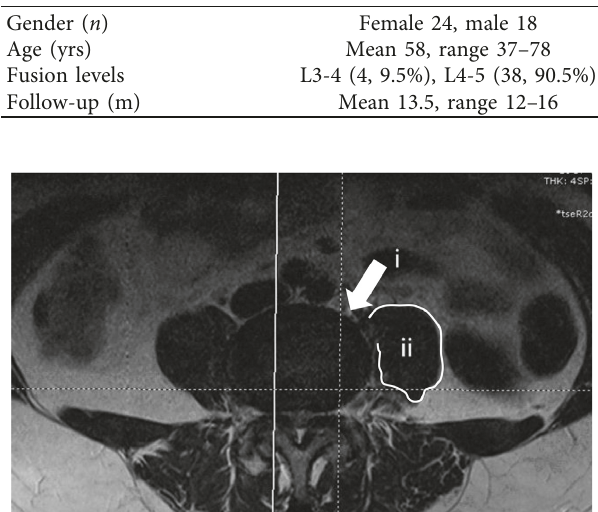
Figure 1: OLIF technology approach. From the space between the psoas muscle (ii) and blood vessel to the target intervertebral space (i).